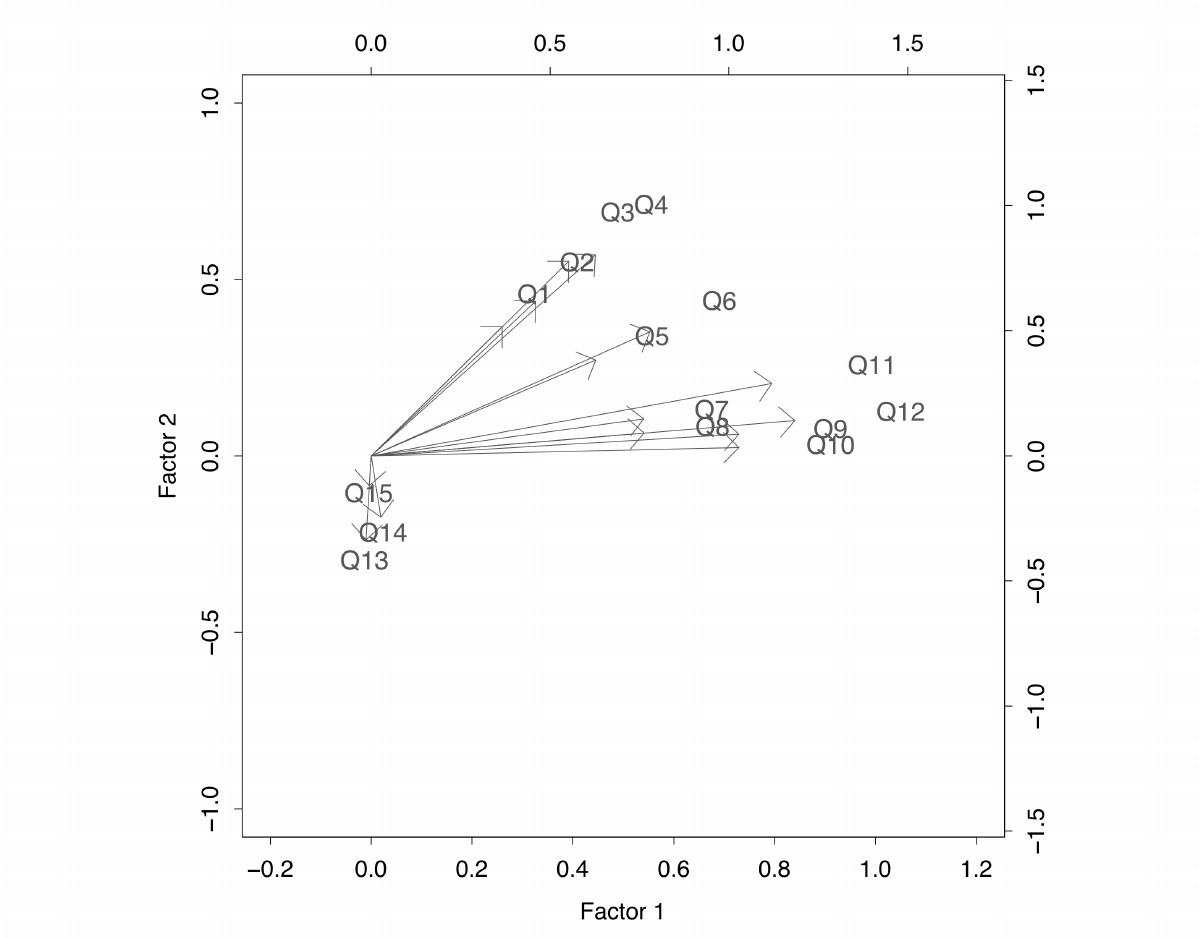
Figure 1. Biplot of Covariance